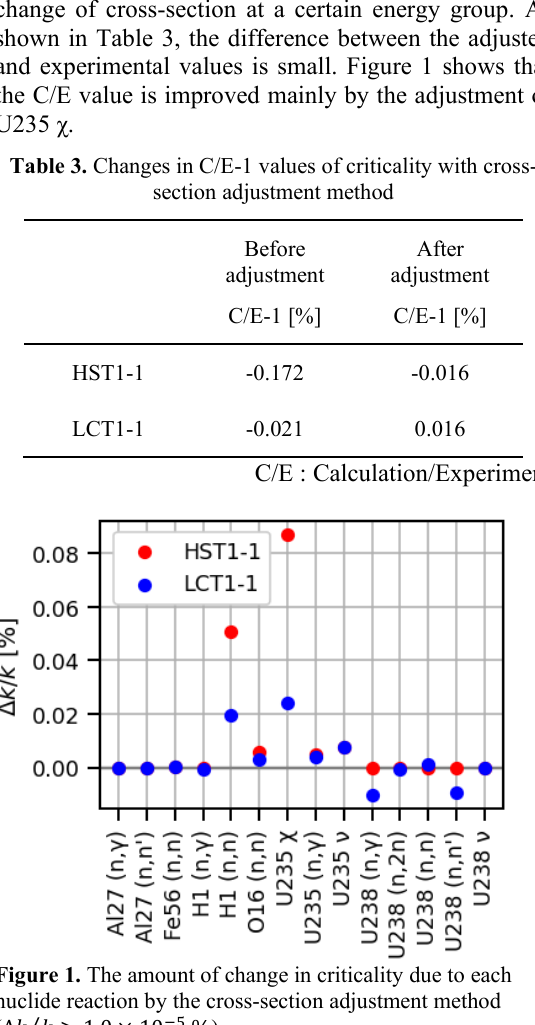
Table 4 . The relative uncertainty differences for